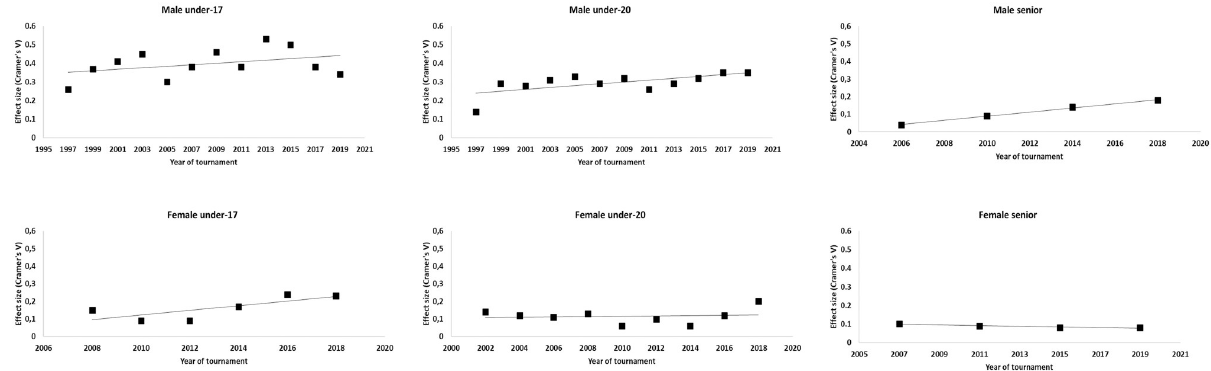
Fig 1. Scatterplots of effect sizes for RAE across gender, level and tournaments (top graphs for males, bottom graphs for females).